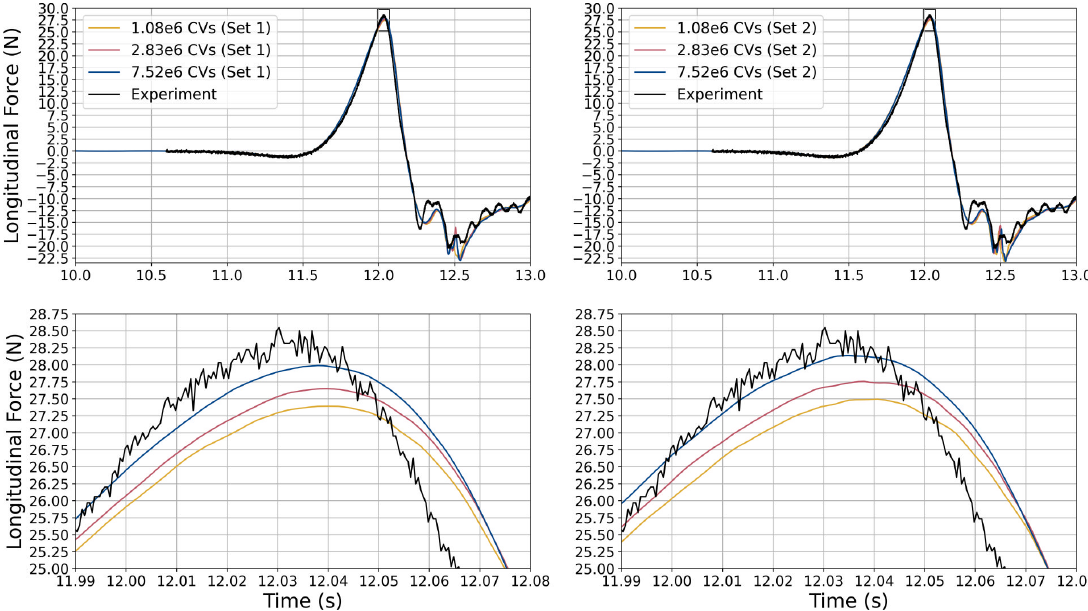
Figure 6. Time histories of wave ‐ induced loads acting on the large cylinder obtained on the three grids of set 1 ( top left ) and set 2 ( top right ) and zoomed views of the associated load peaks of set 1 ( bottom left ) and set 2 ( bottom right ) based on the turbulent flow model. The data were from ref. [11].